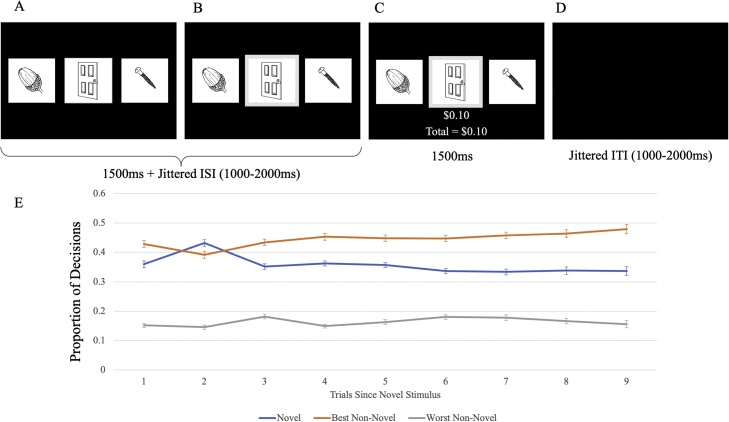
Diagram of the Novelty Task. The Novelty Task is a three-armed bandit task where: A) Three stimuli are presented at the beginning of each trial. B) Participant chooses one of the three stimuli. C) Participant receives feedback ($0-$0.30) based on the stimulus chosen on that trial. D) Intertrial interval between trials. E) Proportion of Novel, Best Non-Novel, and Worst Non-Novel stimuli chosen as a function of number of trials since a new novel stimulus is presented. Participants chose the novel stimulus most often on the second trial after a novel stimulus is presented.